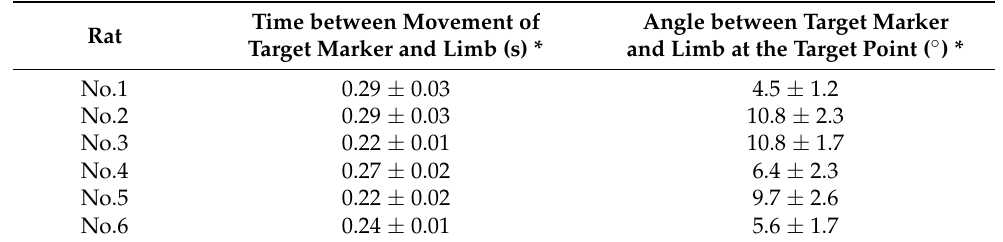
Table 1. Accuracy of visual feedback control using the novel nerve stimulator during 10 random movements for reinnervated muscles (previously denervated muscles).